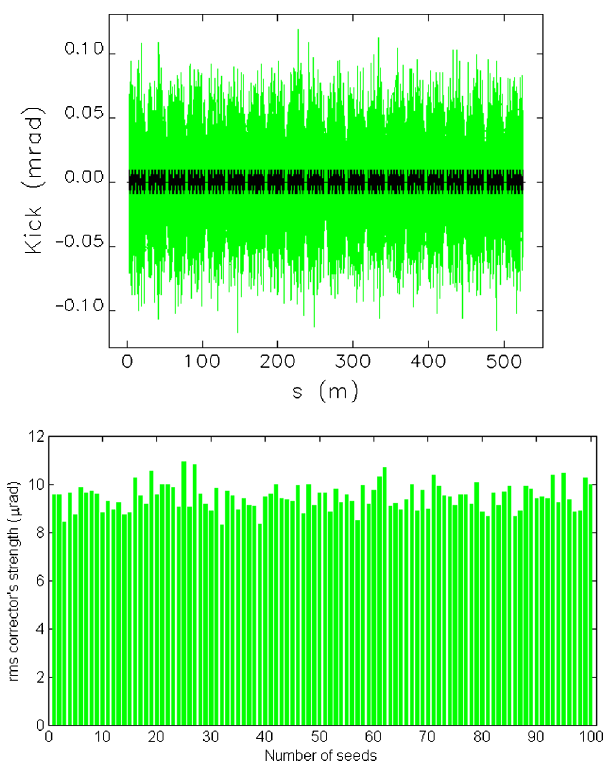
FIG. 11. (top) Strength of the corrector magnets for 100 seeds of random error. (bottom) The rms values of the corrector ’ s strength versus seed